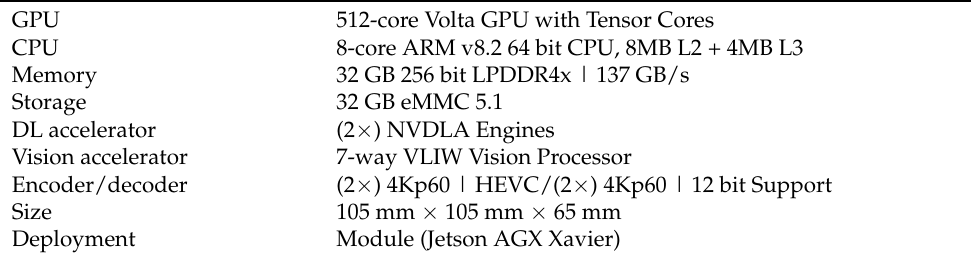
Figure 2. The Jetson AGX Xavier module. Table 1. Technical specifications of the Jetson AGX Xavier